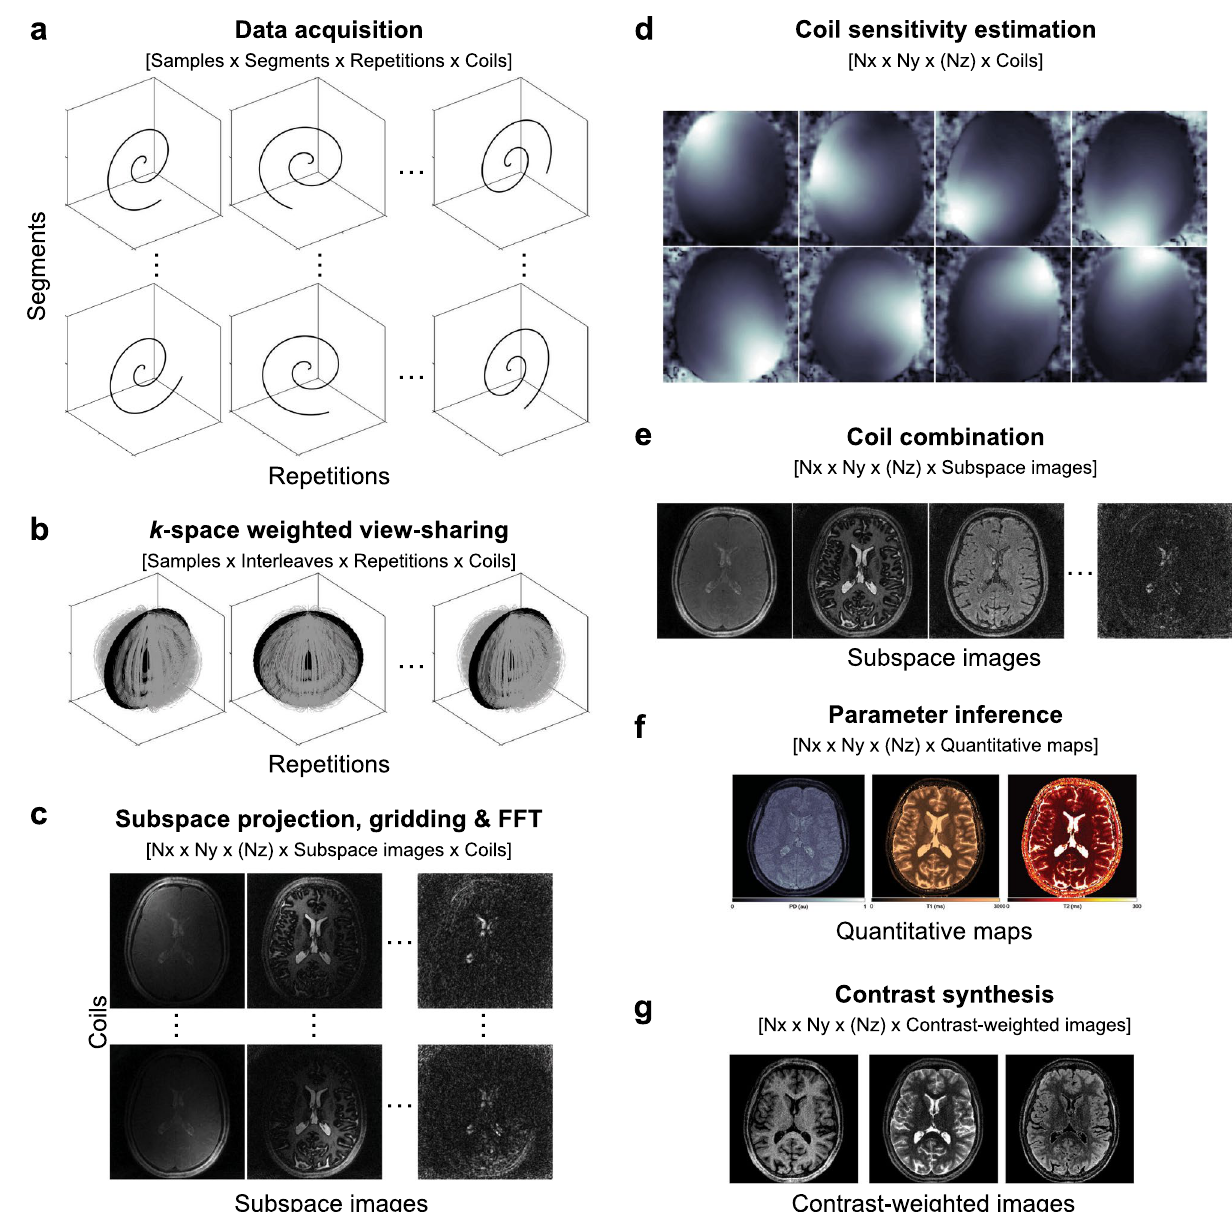
Figure 3. Data acquisition and reconstruction pipeline. ( a ) Undersampled data are acquired throughout different repetitions with unique contrasts and distinct segments with equivalent contrasts. ( b ) k -space weighted view-sharing increases the total amount of acquired samples per repetition. ( c ) Data are dimensionality reduced and reconstructed to produce one image per coil and subspace coefficient. ( d , e ) Sensitivity maps are computed and data from different receiver coils are combined. ( f ) Parameter inference produces quantitative maps as an output. ( g ) The maps can subsequently be used to synthesize contrasts for qualitative